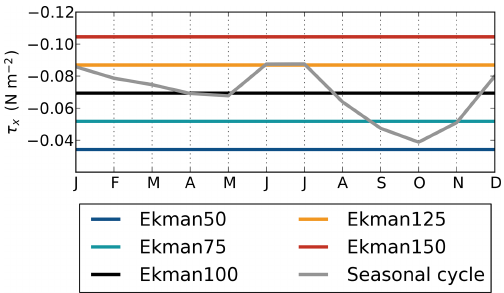
Figure 2. Average zonal wind stress (Nm − 2 ) in the southern Caribbean Sea (10.5–12.5 ◦ N, 65–70 ◦ W) in the simulations. The seasonal variation of the zonal wind stress at this location, obtained from ERA-Interim (Dee et al., 2011), is shown for reference. Nega- tive values correspond to easterly